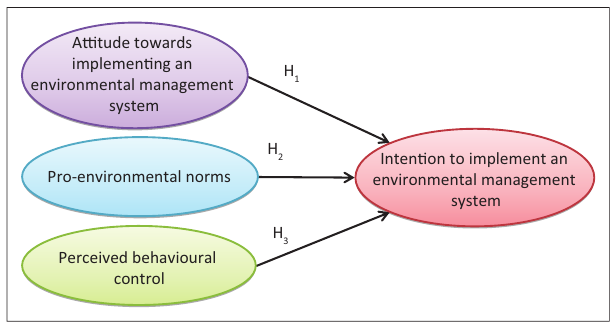
FIGURE 1: Theoretical framework